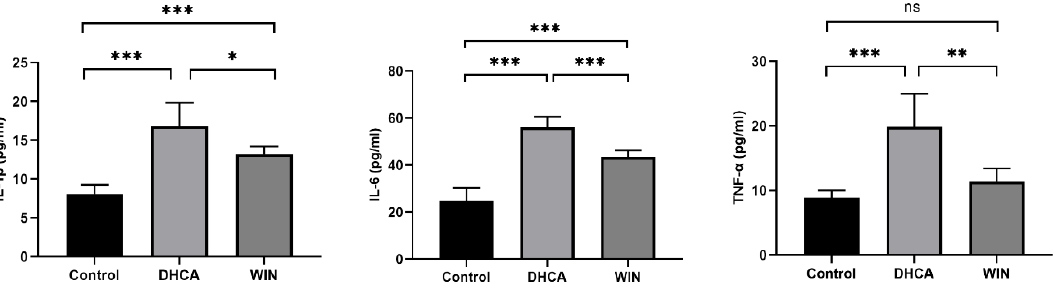
Figure 3. WIN55, 212-2 inhibits the elevation of circulating inflammatory cytokines in rats that underwent DHCA. n = 6. * p < 0.05, ** p < 0.01, and *** p < 0.001. ns, no significance. DHCA, deep hypothermia circulatory arrest. WIN: WIN55, 212-2.